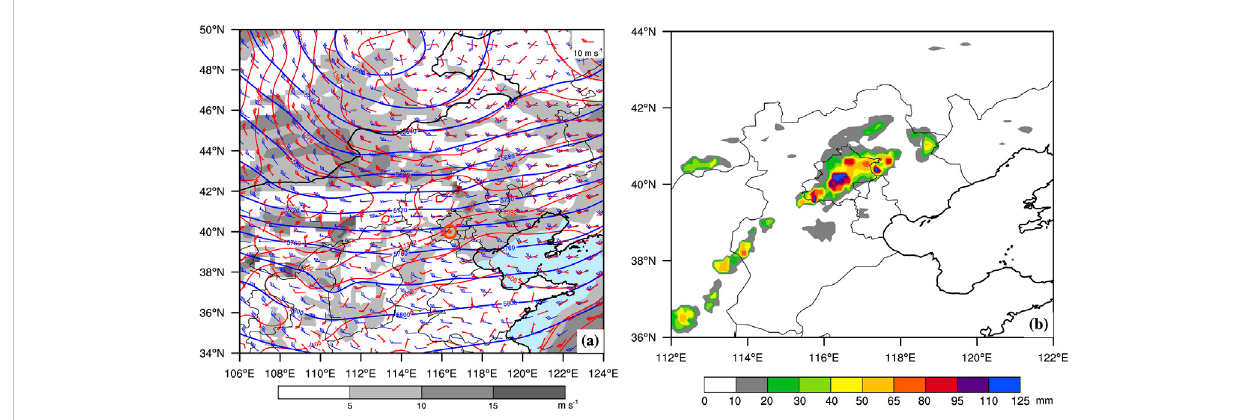
FIGURE 3 (A) Horizontal distributions of the 500 hPa (blue solid lines; gpm), 850 hPa (red solid lines; gpm) geopotential heights and 500 hPa (blue vectors; m s − 1 ), 850 hPa (red vectors; m s − 1 ) wind fi elds with low-level jet at 850 hPa (shaded; m s − 1 ) valid at 1200 UTC 9 August 2020, the red circle marker in (A) denotes the location where banded convective occurred; (B) the observed 6-h total precipitation (shaded; mm) of the National Aeronautics Multi- satellite Retrievals for GPM (IMERG) starting from 1000 UTC 9 August 2020.